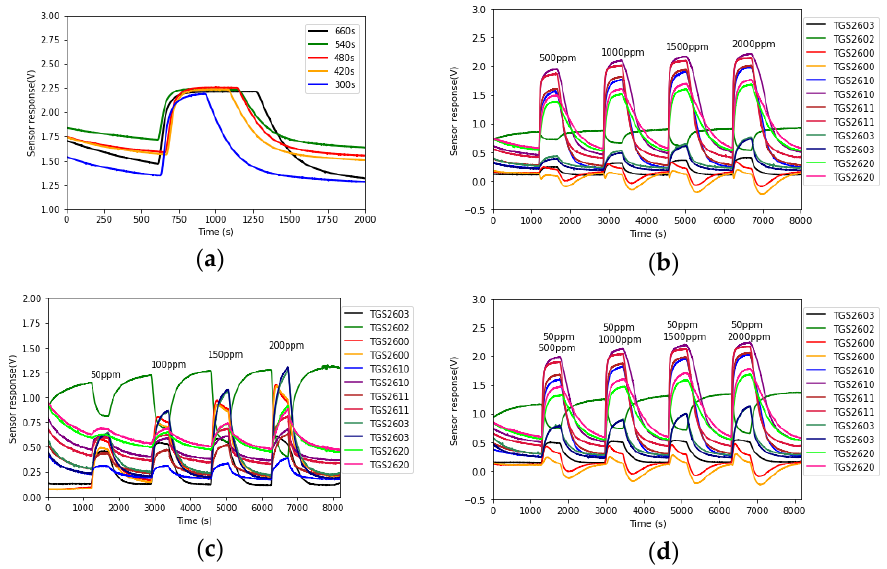
Figure 3. ( a ) Response curves of TGS2603 to CO at 50 ppm concentration at different injecting times; ( b ) Response of 12 sensors to CH 4 at four concentrations; ( c ) Response of 12 sensors to CO at four concentrations; ( d ) Response of 12 sensors to gas mixtures (50 ppm CO + 500~2000 ppm CH 4 ).